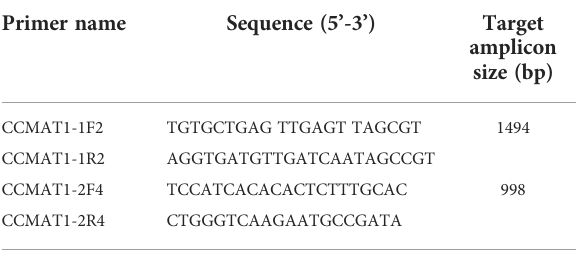
TABLE 2 Primers for multiplex PCR-based mating-type ( MAT1 ) marker in C. cassiicola